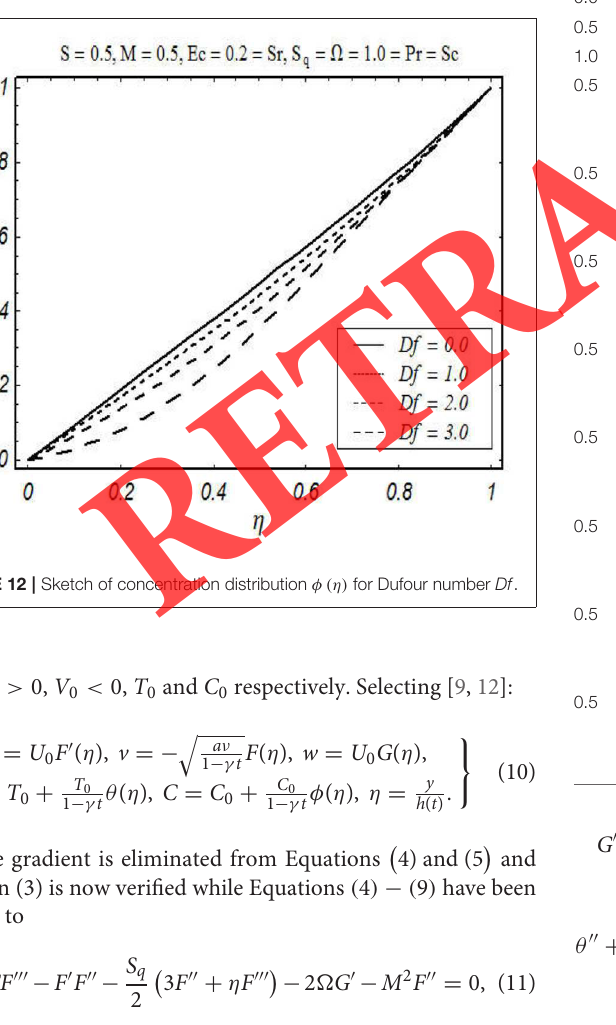
FIGURE 11 | Sketch of concentration distribution φ (η) for Soret number Sr .